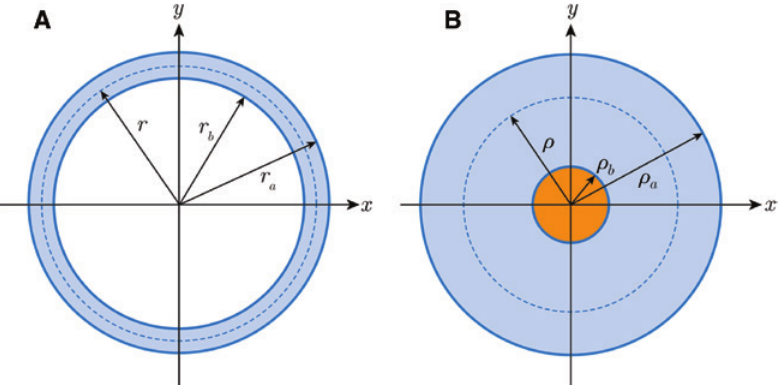
Figure 1: Transformations of concentric circular